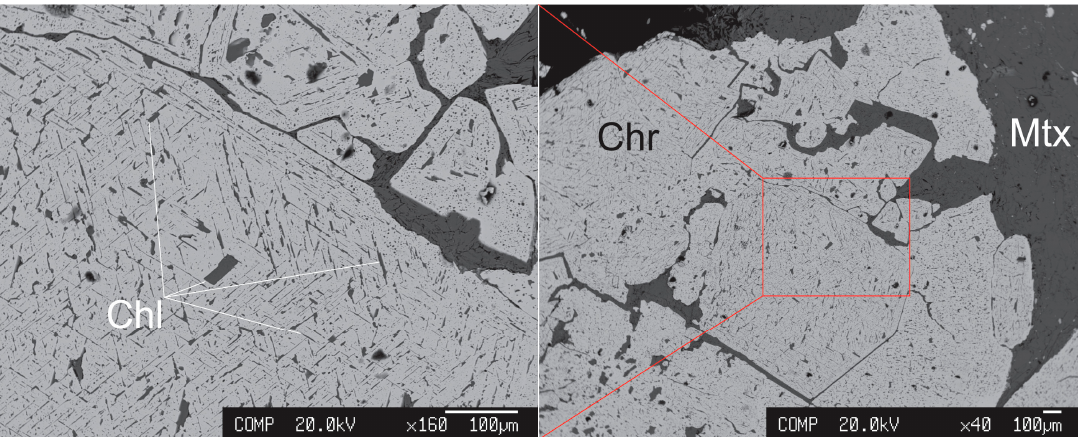
Figure 5. Backscattered electron images of abundant oriented Cr-rich chlorite inclusions in chromite (Sample CED-105) [32]. Abbreviations: Chl = chlorite; Chr = chromite; Mtx =